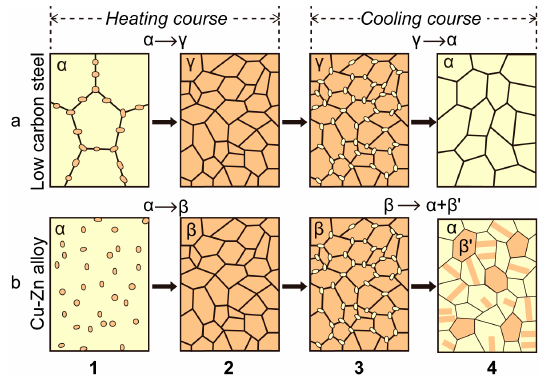
Figure 3. Schematic diagram of phase transition and ultra-fine grains: ( a ) low-carbon steel [77]; ( b ) Cu-Zn alloy [79]: (1) nucleation of γ or β phase, (2) grain growth of γ and β phase, (3) formation of